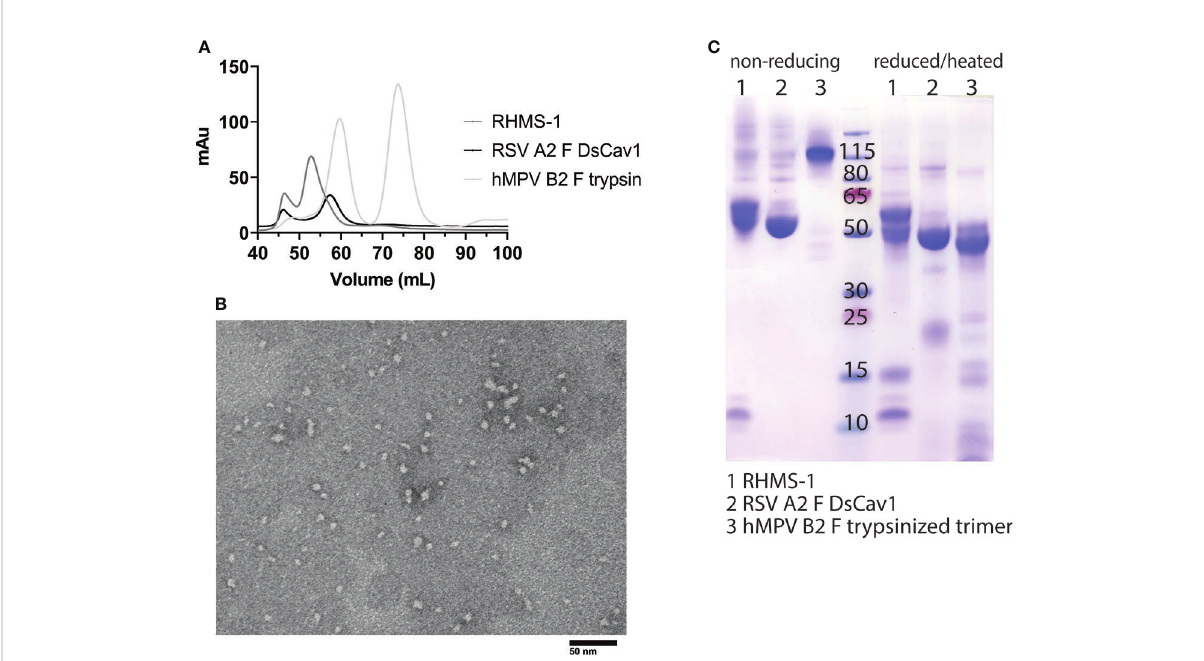
FIGURE 2 Puri fi cation and Negative-stain EM of RHMS-1. (A) Size exclusion chromatography curves of RHMS-1 (gray), RSV A2 F DsCav1 (black), and trypsinized hMPV B2 F (silver). mAu: milli absorbance units. (B) SDS-PAGE of F proteins in non-reducing and reduced/heated conditions. Numbers shown at the marker lane represent kDa values. (C) Representative negative-stain electron micrograph of RHMS-1 obtained from fractions 50-60 mL from the size exclusion chromatogram shown in (A)